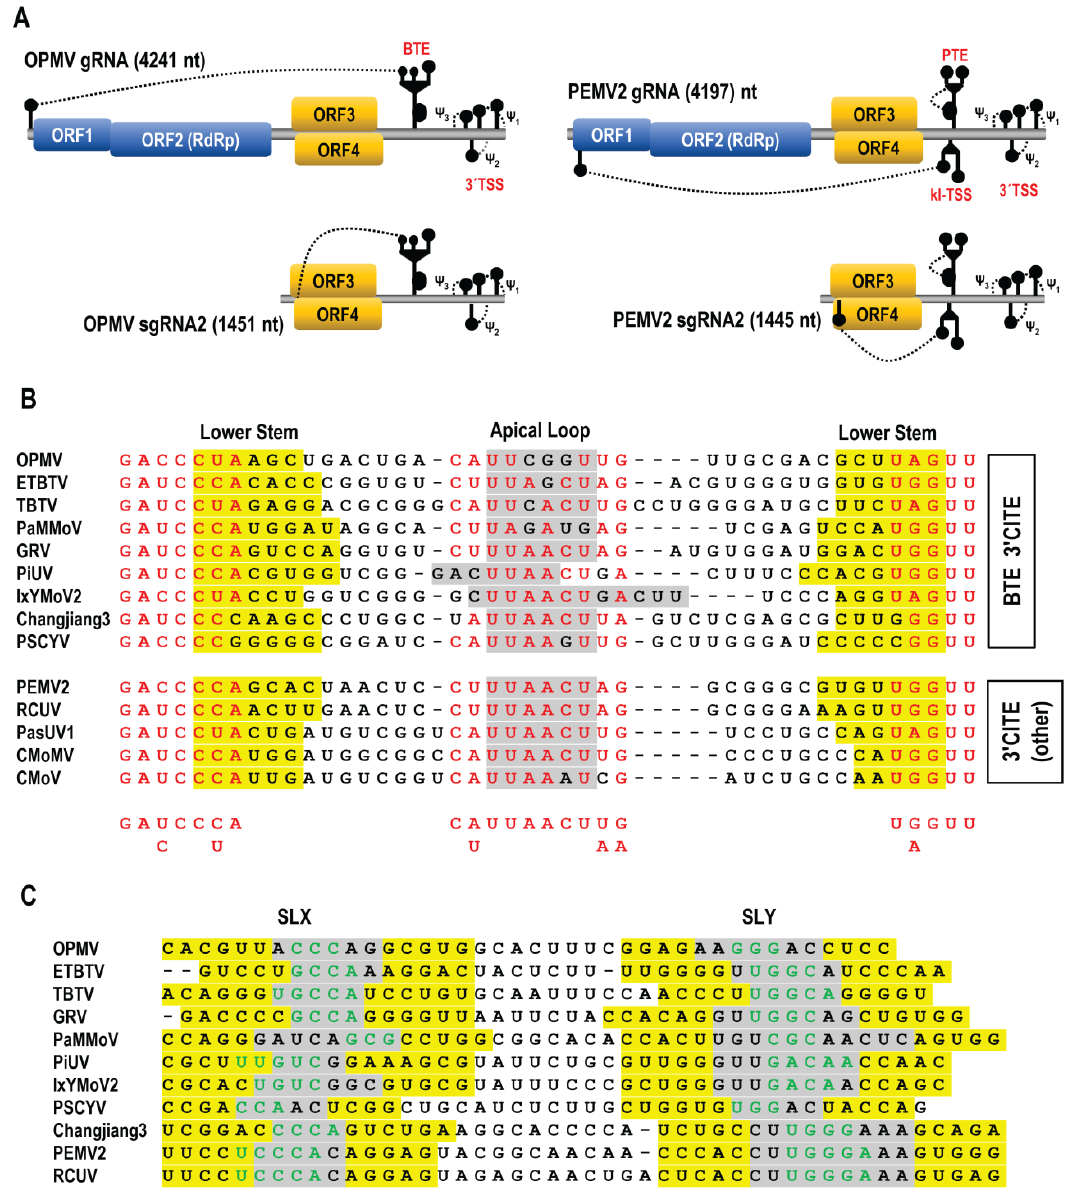
Figure 1. Novel conserved structures in the 3 (cid:48) UTRs of umbraviruses. ( A ). Umbravirus genome organization. ORFs encoding replication-required proteins are in blue, and movement proteins are in orange. A second, slightly larger sgRNA is present in some umbraviruses, including OPMV. 3 (cid:48) CITEs are shown along with the long-distance interaction (dashed line) connecting some 3 (cid:48) CITEs to the 5 (cid:48) end. Other tertiary interactions near the 3 (cid:48) end are also shown. ( B ). Sequence alignment in the CAS region. Conserved residues are in red. Residues in the CAS apical loop are shaded gray, and residues in the lower stem are shaded yellow. ( C ). Conserved structures just upstream of CAS in 11 umbraviruses. Two hairpins (SLX and SLY) are denoted with stem sequences in yellow and apical loops in gray. Putative kissing loop sequences are in green. OPMV, opium poppy mosaic virus; ETBTV, Ethiopian tobacco bushy top virus; TBTV, tobacco bushy top virus; PaMMoV, patrinia mild mottle virus; GRV, groundnut rosette virus; PiUV, picris umbravirus 1; IxYMoV2, ixeridium yellow mottle virus; Changjiang3, Changjiang tombus-like virus 3; PSCYV, paederia scandens chlorosis yellow virus; PEMV2, pea enation mosaic virus 2; RCUV, red clover umbravirus; PasUV1, Paederia scandens chlorosis yellow umbravirus; CMoMV; carrot mottle mimic virus; CMoV, carrot mottle